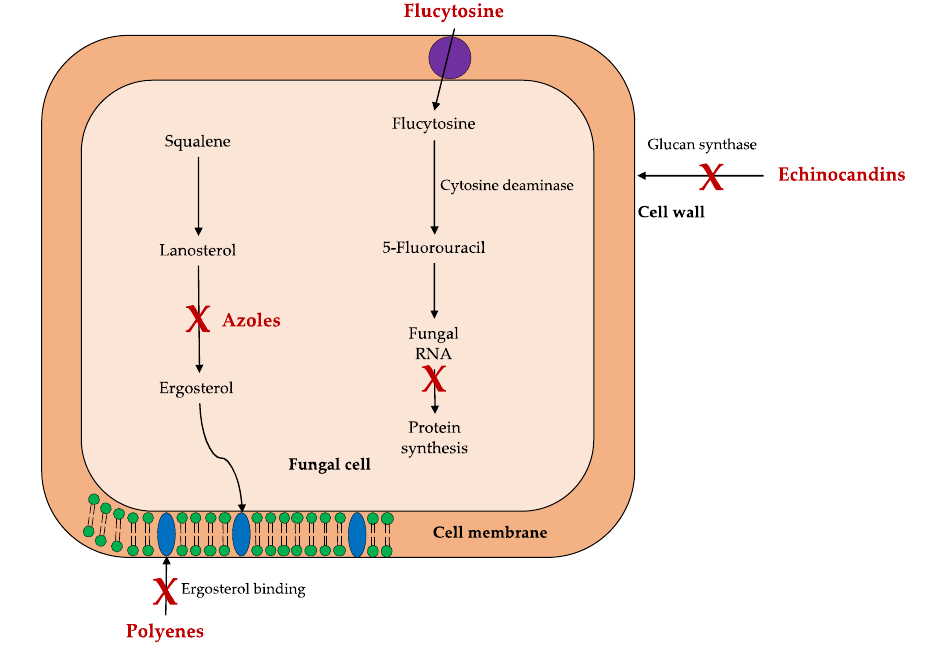
Figure 1. Mechanism of action of antifungal classes.